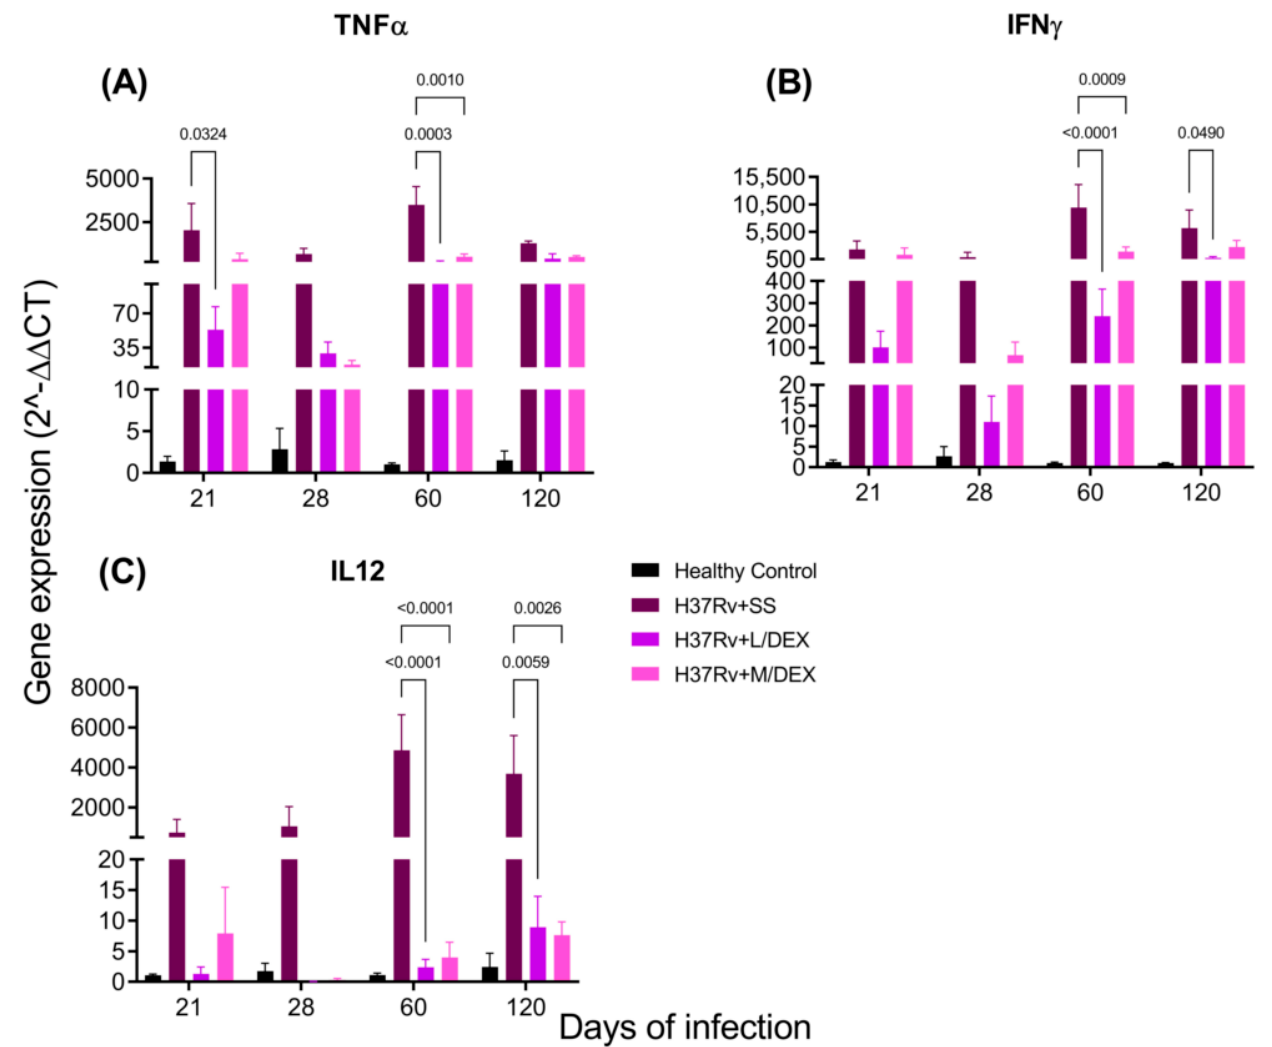
Figure 8. Effect of IN L/DEX (0.05 mg/kg BW) and M/DEX (0.25 mg/kg BW) on pro-inflammatory cytokines of the cerebellum of mice infected with Mtb H37Rv. ( A ) TNF α . F (3, 8) = 5.228, p = 0.0273. REML. Dunnett’s multiple comparisons test. ( B ) IFN γ . F (3, 8) = 6.175, p = 0.0177. REML. Dunnett’s multiple comparisons test. ( C ) IL-12. F (3, 29) =